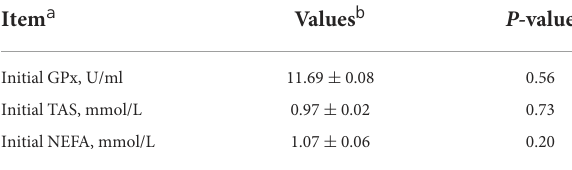
TABLE 1 Initial measurements from ewes arriving to the trial used as covariates in the analysis of data, values were not different by treatment thereby an average value is